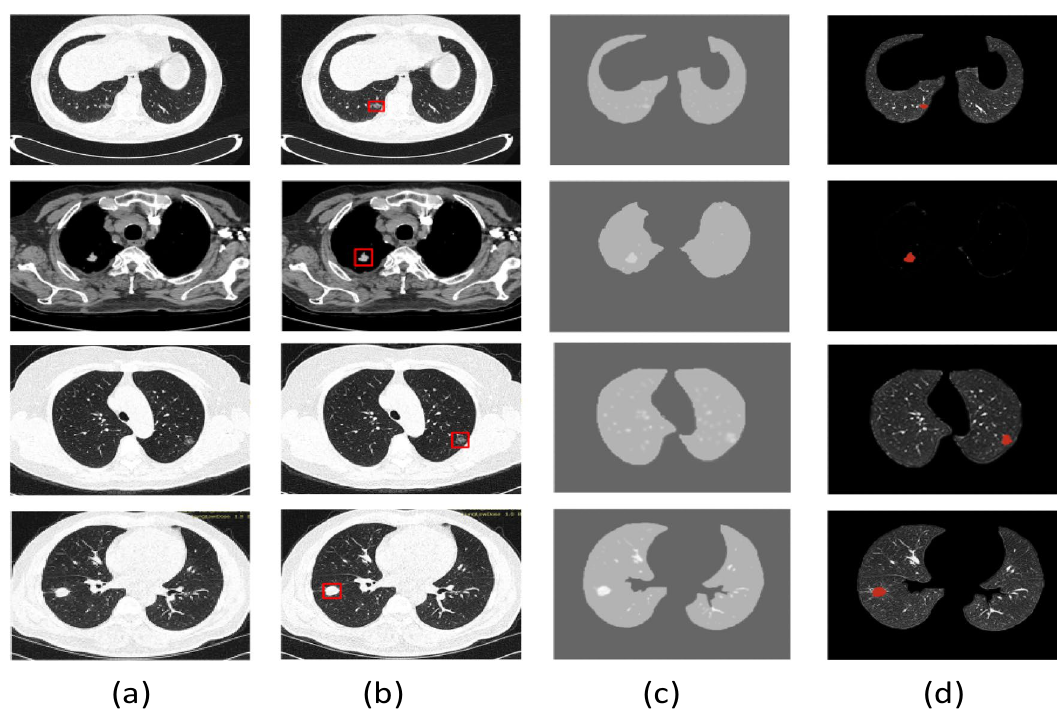
Figure 6. The detection and segmentation result for different kind of pulmonary nodules ( a ) normal original data ( b ) labeled data lesion area ( c ) segmentation data ( d ) multi-scale filtering enhancement